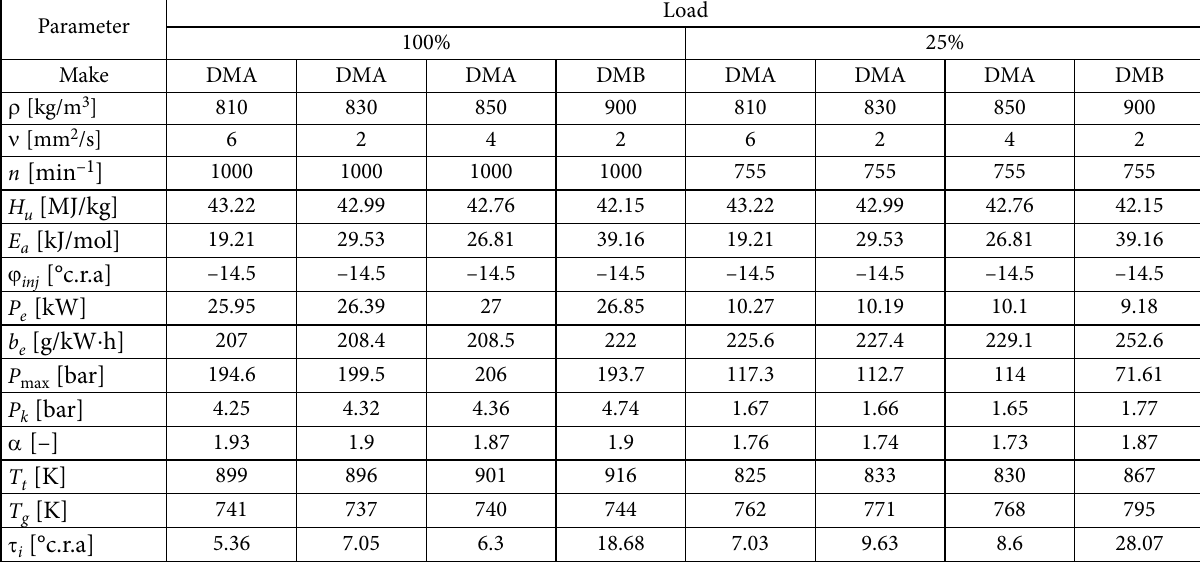
Table B2. Influence of MBF properties on diesel engine ChN 26.5/31